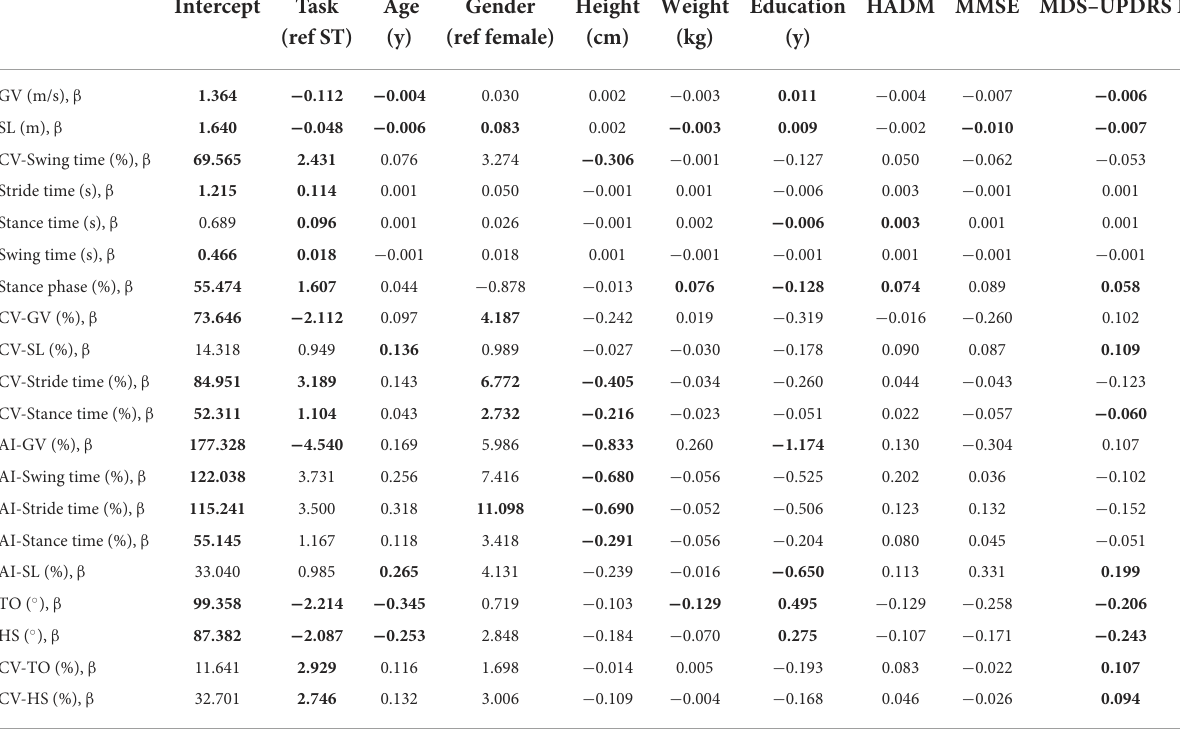
TABLE 3 Influences of clinical features on the gait parameters in early-stage PD group. Intercept Task Age